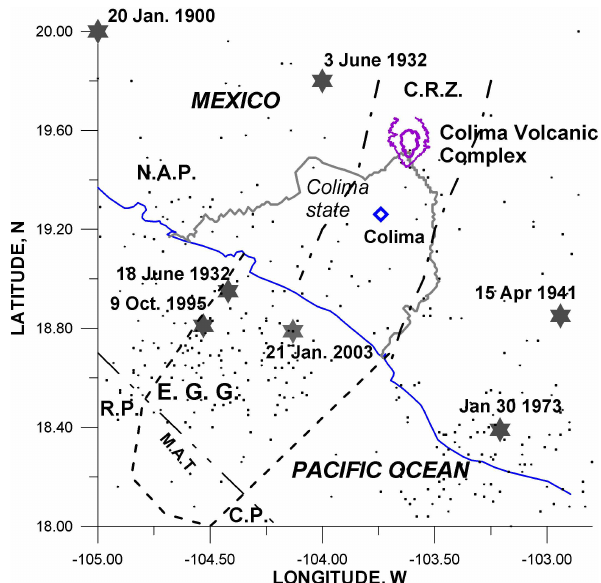
Fig. 1. Seismo-tectonic environment of Colima city. Lithospheric plates are shown (N.A.P., North American Plate; R.P., Rivera Plate; C.P., Cocos Plate), the Middle American Trench (M.A.T., long- dashed line), the limits of the El Gordo Graben (E.G.G., short- dashed line) and the limits of the Colima Rift Zone (C.R.Z., dashed- dotted line). The stars with date show the epicenters and the date of the M w ≥ 7.3 earthquakes that occurred near Colima city dur- ing the 20th and 21st centuries. The points show the epicenters of the M ≥ 3.5 earthquakes occurring during last 10years. The border of Colima state is shown by a grey line. The position of Colima city is shown by a diamond. The epicenters of the 1932, 1941, and 1973 earthquakes are shown according to Pacheco and Sykes (1992), the 1995 earthquake according to Zobin and Ventura- Ram´ırez (1998) and the 2003 earthquake according to Zobin and Pizano-Silva